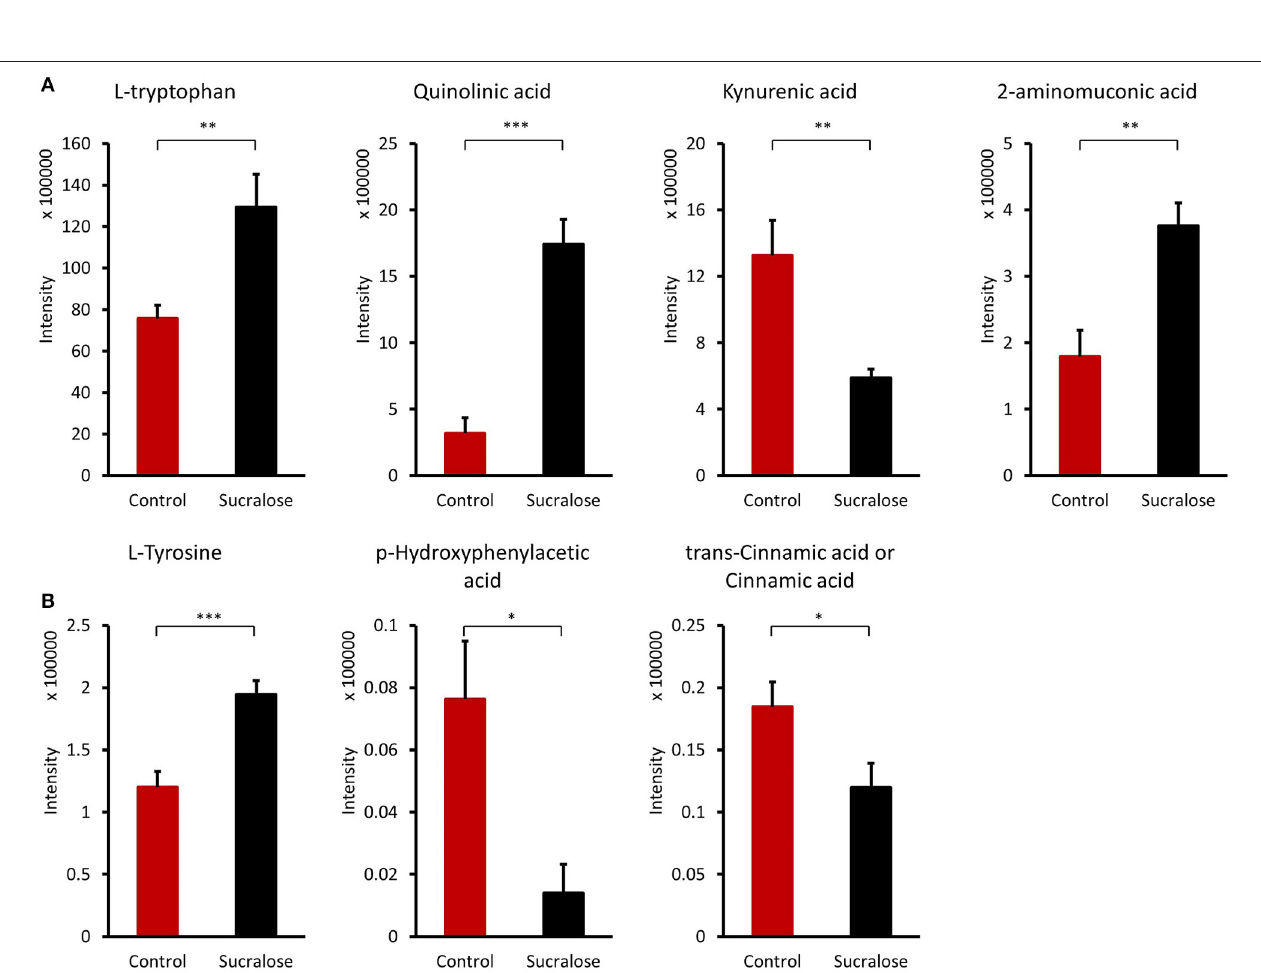
Frontiers in Physiology |